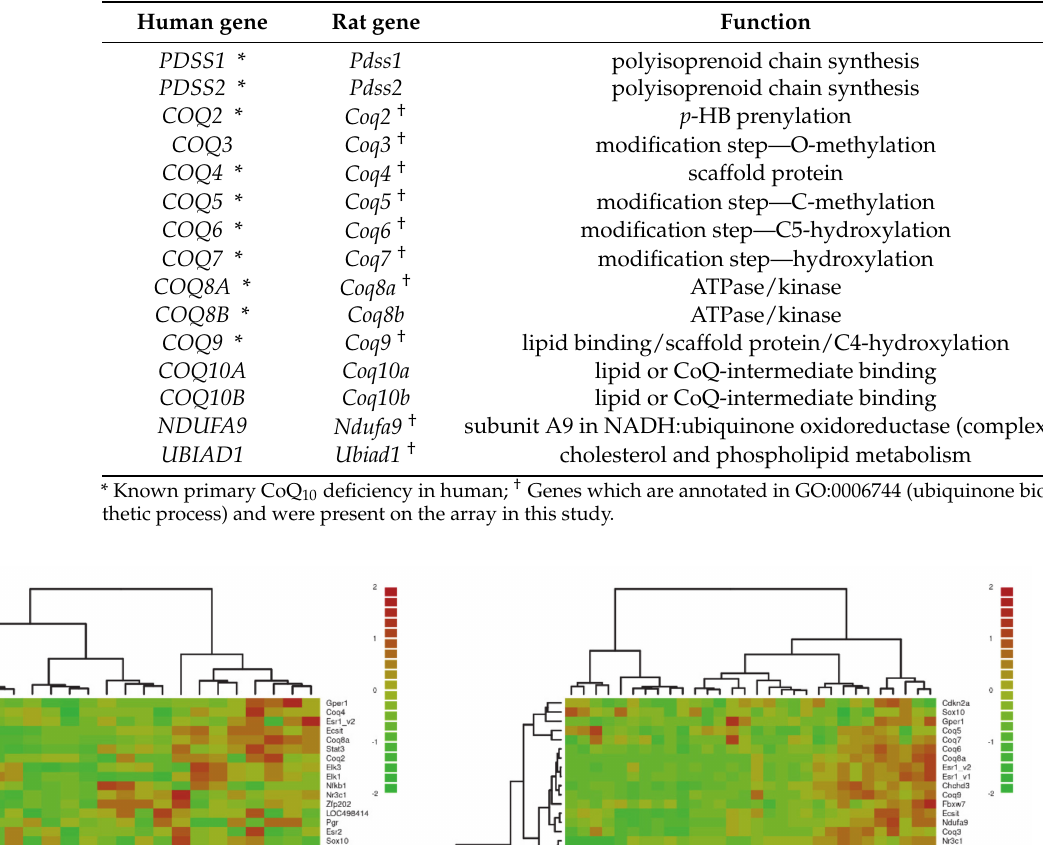
Table 3. Genes involved in CoQ biosynthesis. GO:0006744 (ubiquinone biosynthetic process) was not detected as significantly enriched among mitochondrial genes either in the rat liver or skeletal muscle (FDR > 0.05).